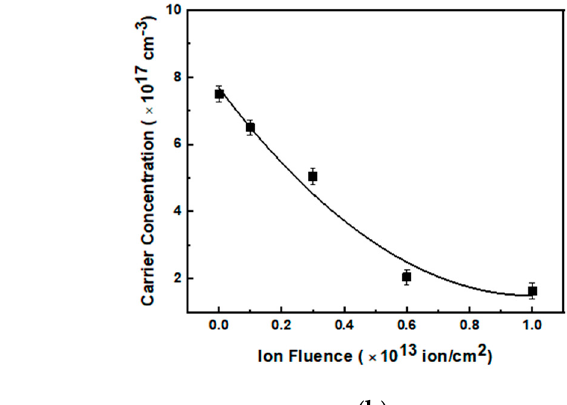
Figure 4. Capacitance–voltage (C–V) curves of un-irradiated and of irradiated diodes at different fluences ( a ). Dopant concentration as a function of ion fluence calculated by C–V measurements ( b ).